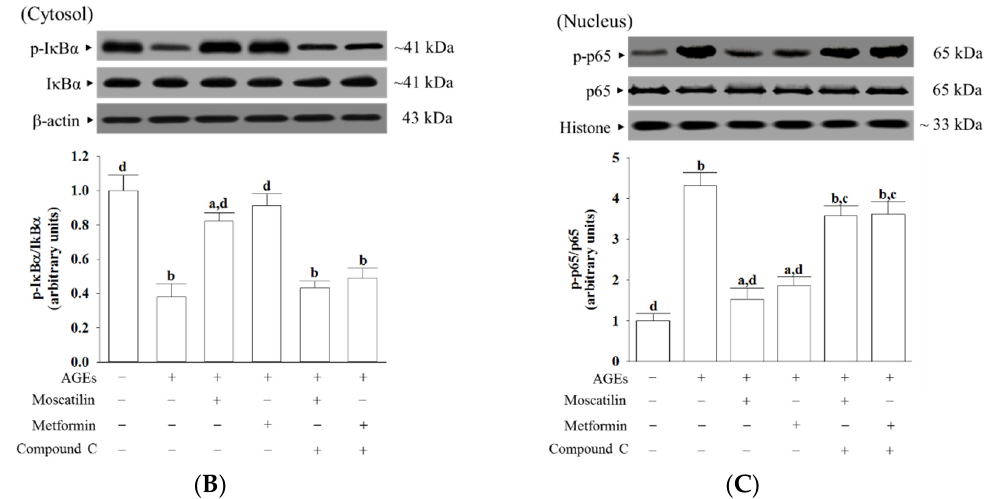
Figure 5. Effects on the AMPK and NF- κ B signaling in AGEs-treated SH-SY5Y cells. Cells were pretreated with moscatilin (1 μ mol/L) or metformin (2 μ mol/L) for 1 h, followed by exposure to 50 μ g/mL AGEs for another 24 h. Compound C (5 μ mol/L) was added 1 h before moscatilin or metformin were stimulated. The photographs represent the Western blots for ( A ) p-AMPK α and AMPK α , ( B ) p-I κ B α and I κ B α , ( C ) p-p65 and p65. The densities of protein bands were quantitated and the ratios of p-AMPK α / AMPK α , p-I κ B α / I κ B α and p-p65 / p65 were calculated and shown in the bottom panels. The results are presented as the mean ± SD of five independent experiments ( n = 5), each of which was performed in triplicate. a p < 0.05 and b p < 0.01 compared to the data from untreated group (vehicle control). c p < 0.05 and d p < 0.01 when compared to the data from cells cultured under AGEs without any treatment.